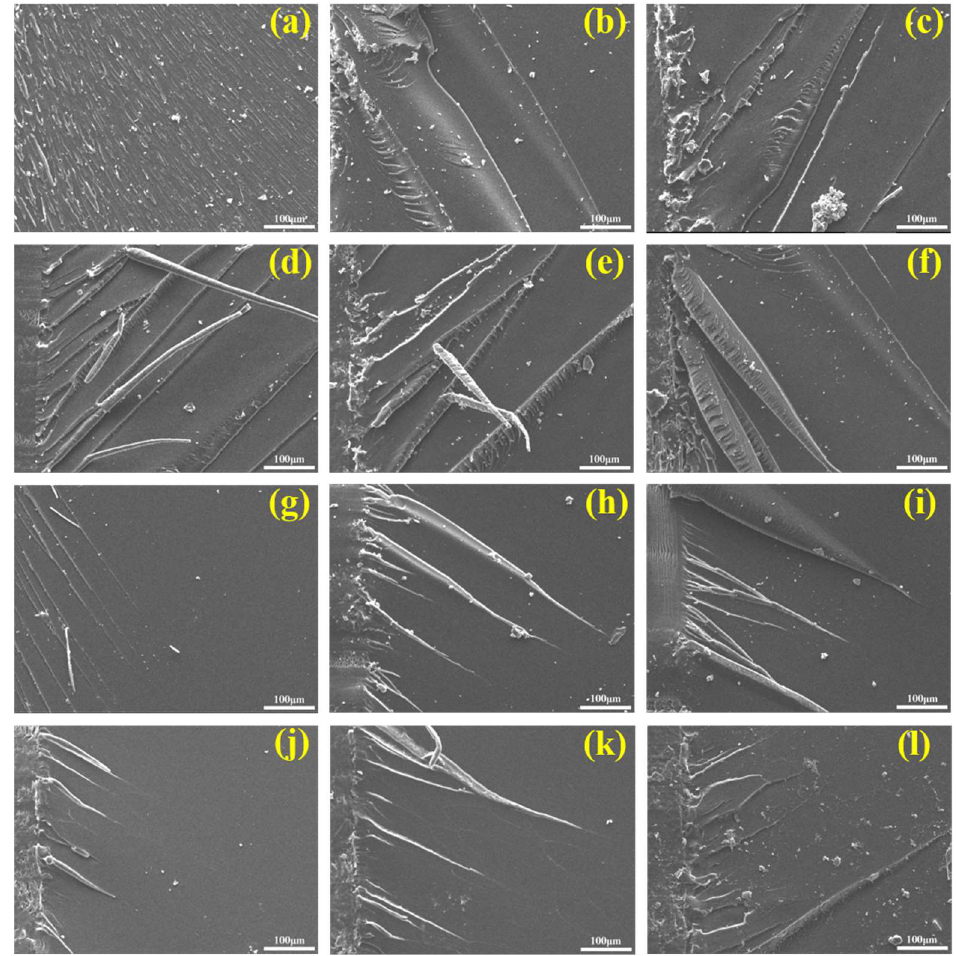
Figure 10. SEM images of the fracture surfaces of the cured EP: ( a ) pure EP, ( b ) EP/BCI-25, ( c ) EP/BCI/BSEA-2, ( d ) EP/BCI/BSEA-3, ( e ) EP/BCI/BSEA-4, ( f ) EP/BCI/BSEA-5 at RT, ( g ) pure EP, ( h ) EP/BCI-25, ( i ) EP/BCI/BSEA-2, ( j ) EP/BCI/BSEA-3, ( k ) EP/BCI/BSEA-4, ( l ) EP/BCI/BSEA-5 at 77 K.